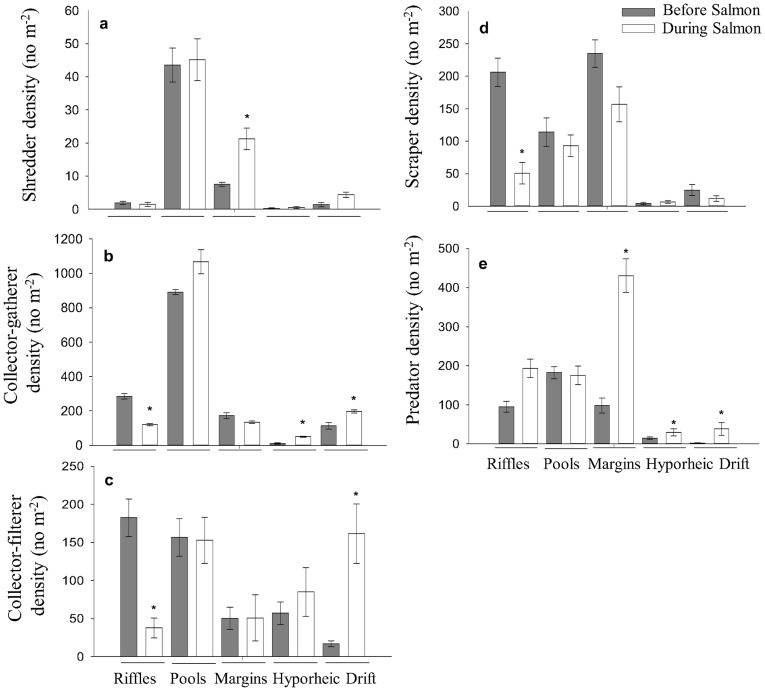
Functional feeding group differences before and during spawning.Shredder (a), Collector-gatherer (b), Collector-filterer (c), Scraper (d), and Predator (e) densities before (dark grey bars) and during (white bars) the salmon run in riffles, pools, margins, the hyporheic zone, and drift. Graphs shows +/−1 s.e. and * means p<0.05.